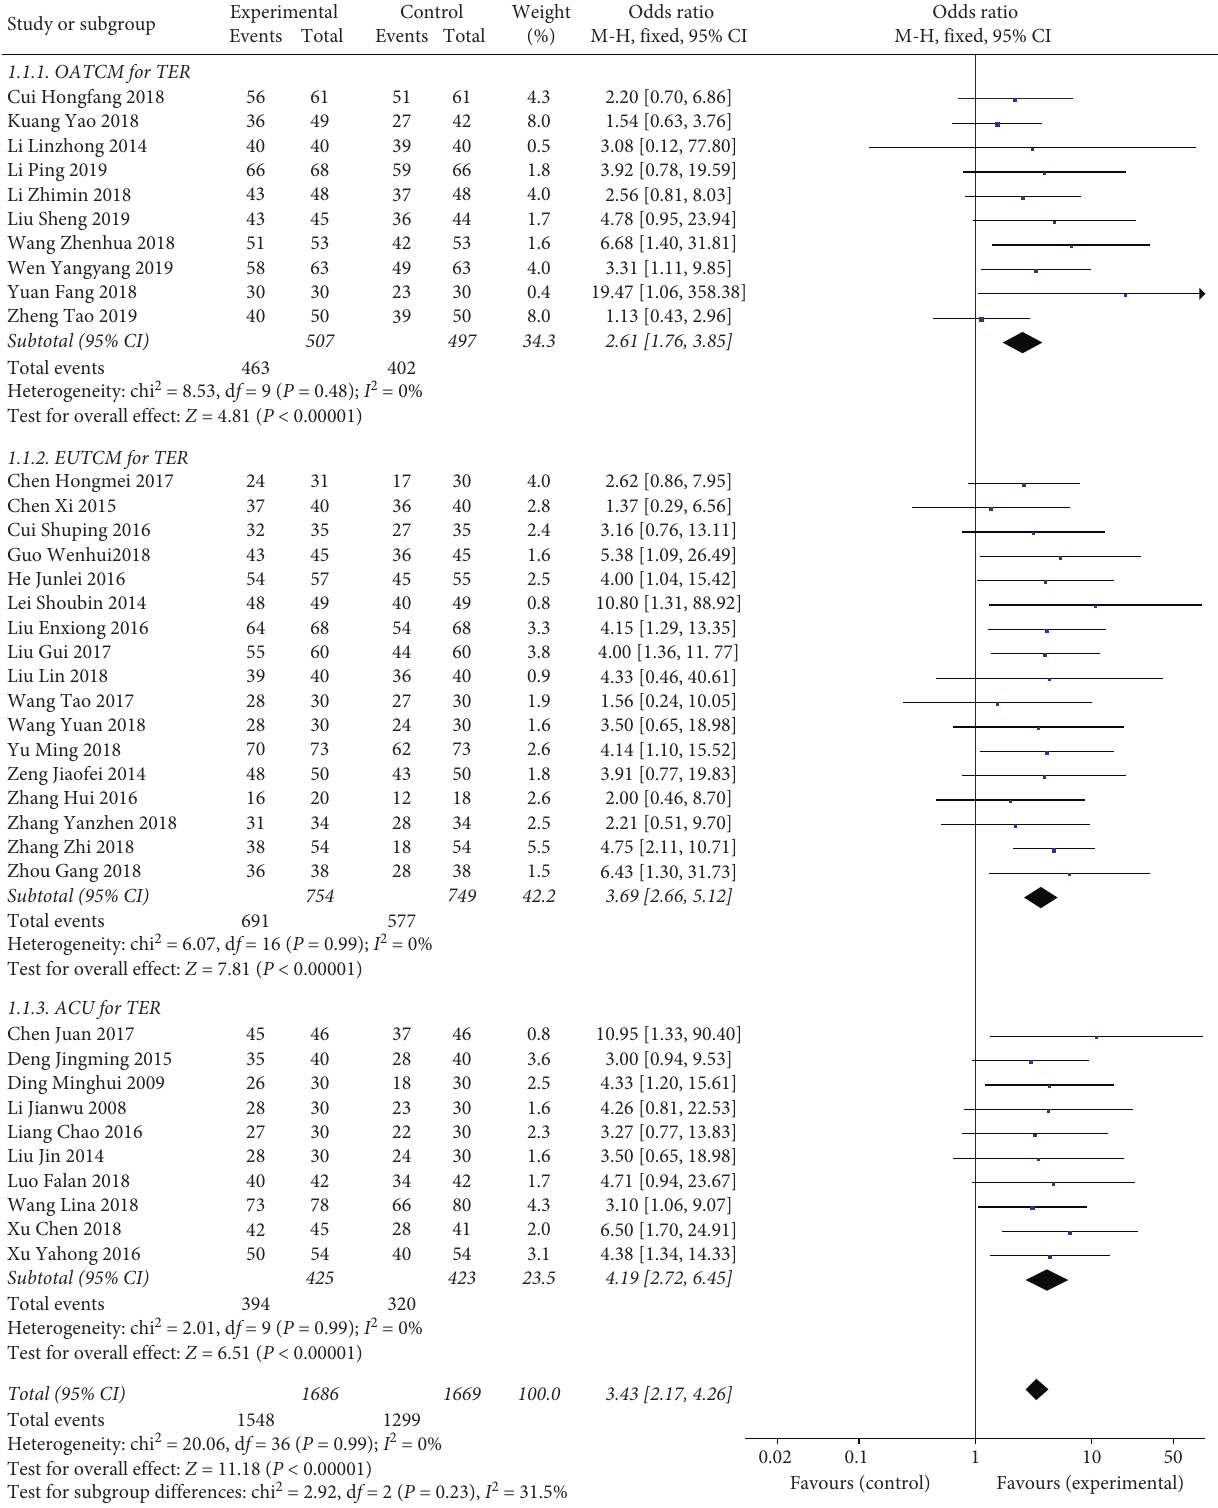
50 Favours (experimental) Test for subgroup differences: chi 2 = 2.92, d f = 2 ( P = 0.23), I 2 = 31.5%